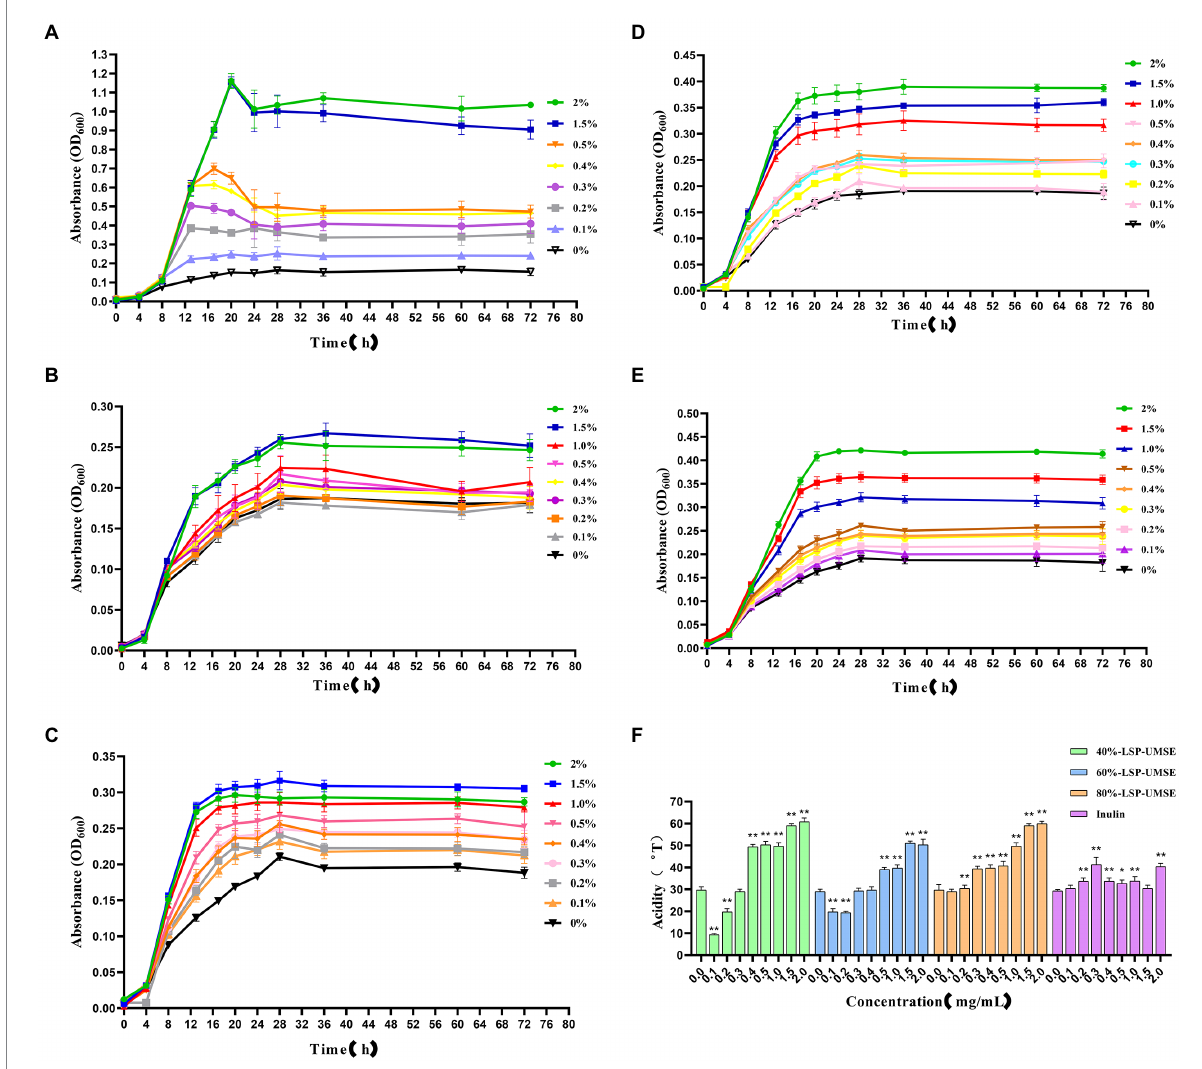
FIGURE 9 Growth curves of L. casei cultured at different carbon source concentrations and acidity values after 24 h incubation at different carbon source concentrations. (A) Glucose carbon source; (B) inulin carbon source; (C) 40%-LSP-UMSE carbon source; (D) 60%-LSP-UMSE carbon source; (E) 80%-LSP-UMSE carbon source; (F) acidity comparison of different carbon source concentrations at 24 h (Note: 0 mg/ml was used as control, * was significantly p < 0.05, ** was extremely significantly p <